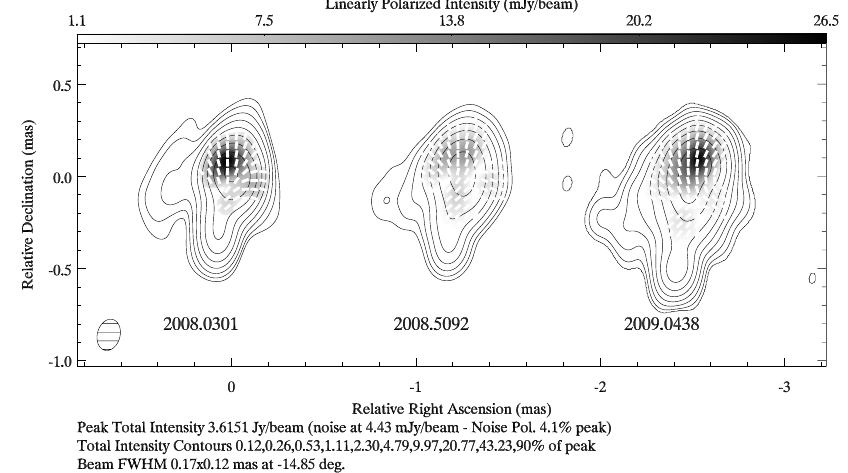
Figure 2. Sequence of three VLBA images at 43 GHz from 2008 to 2009. Contours show the 43 GHz total intensity. Grey scale represents the linearly polarized intensity, and the short white sticks indicate the electric vector position angle distribution. A common convolving beam, as shown in the lower-left corner of the plot, was used for all images.